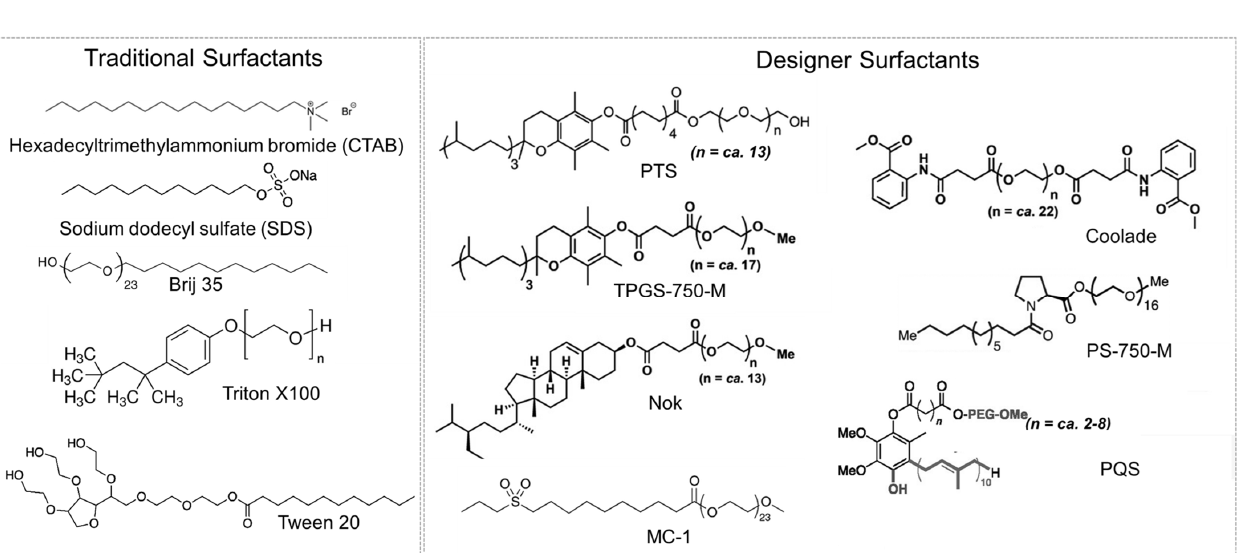
Figure 3. Structures of traditional surfactants and designer surfactants commonly used for organic reactions in water.